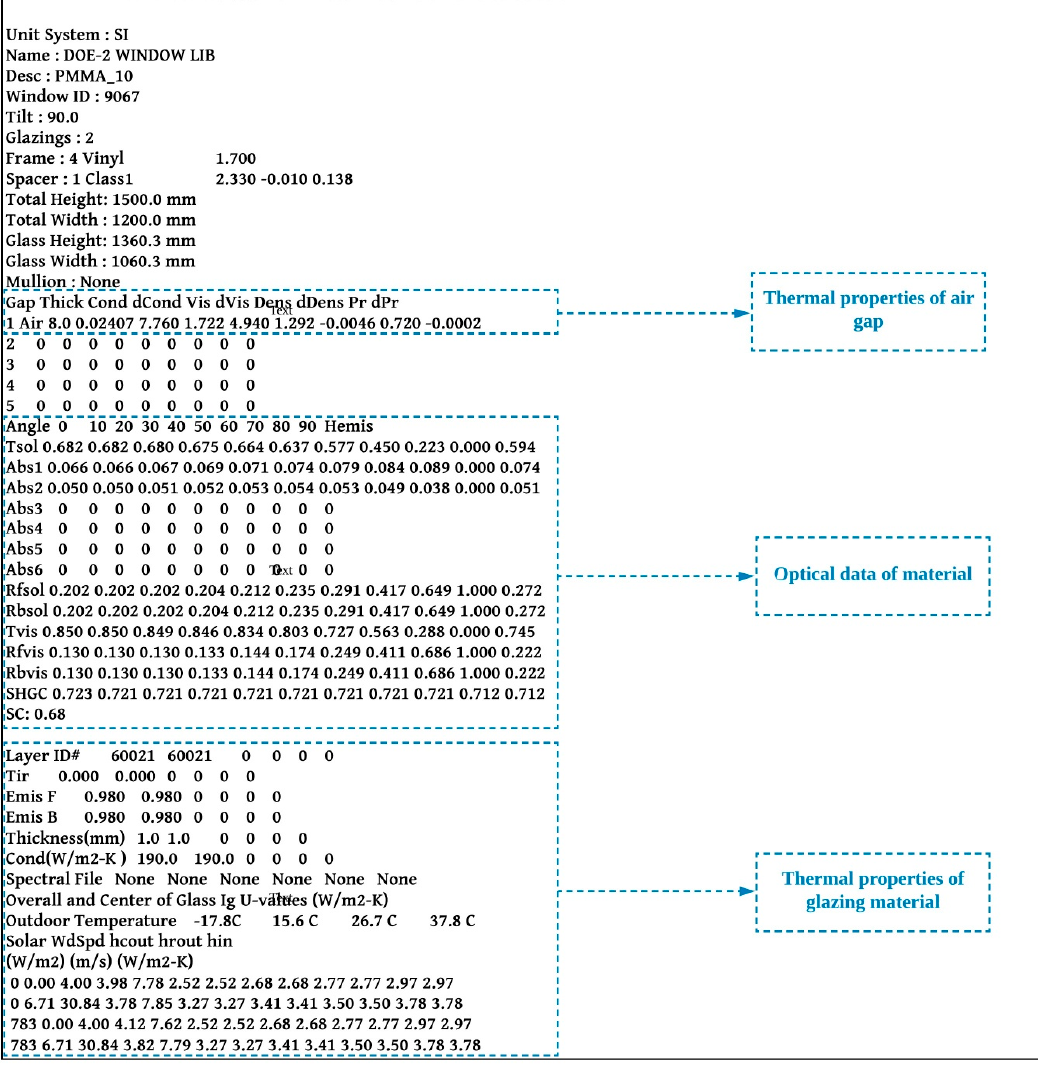
Figure 6. Sample of the DOE ‐ 2 file for PMMA (Polymethylmethacrylate).